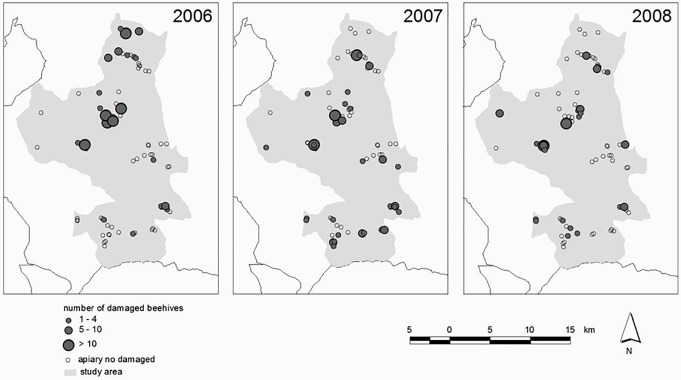
Locations of damaged and undamaged apiaries in the study area in 2006–2008.For damaged apiaries, the number of damaged beehives is also shown.